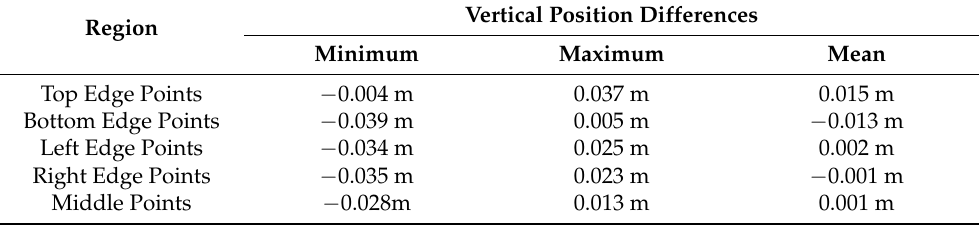
Table 9. Quantitative measures for the vertical position differences of points within the five regions of interest for flight A.